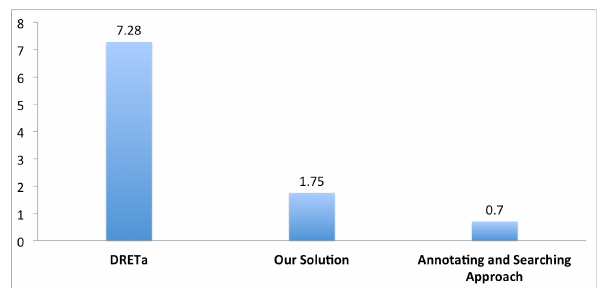
Figure 4 Comparisons of table extraction